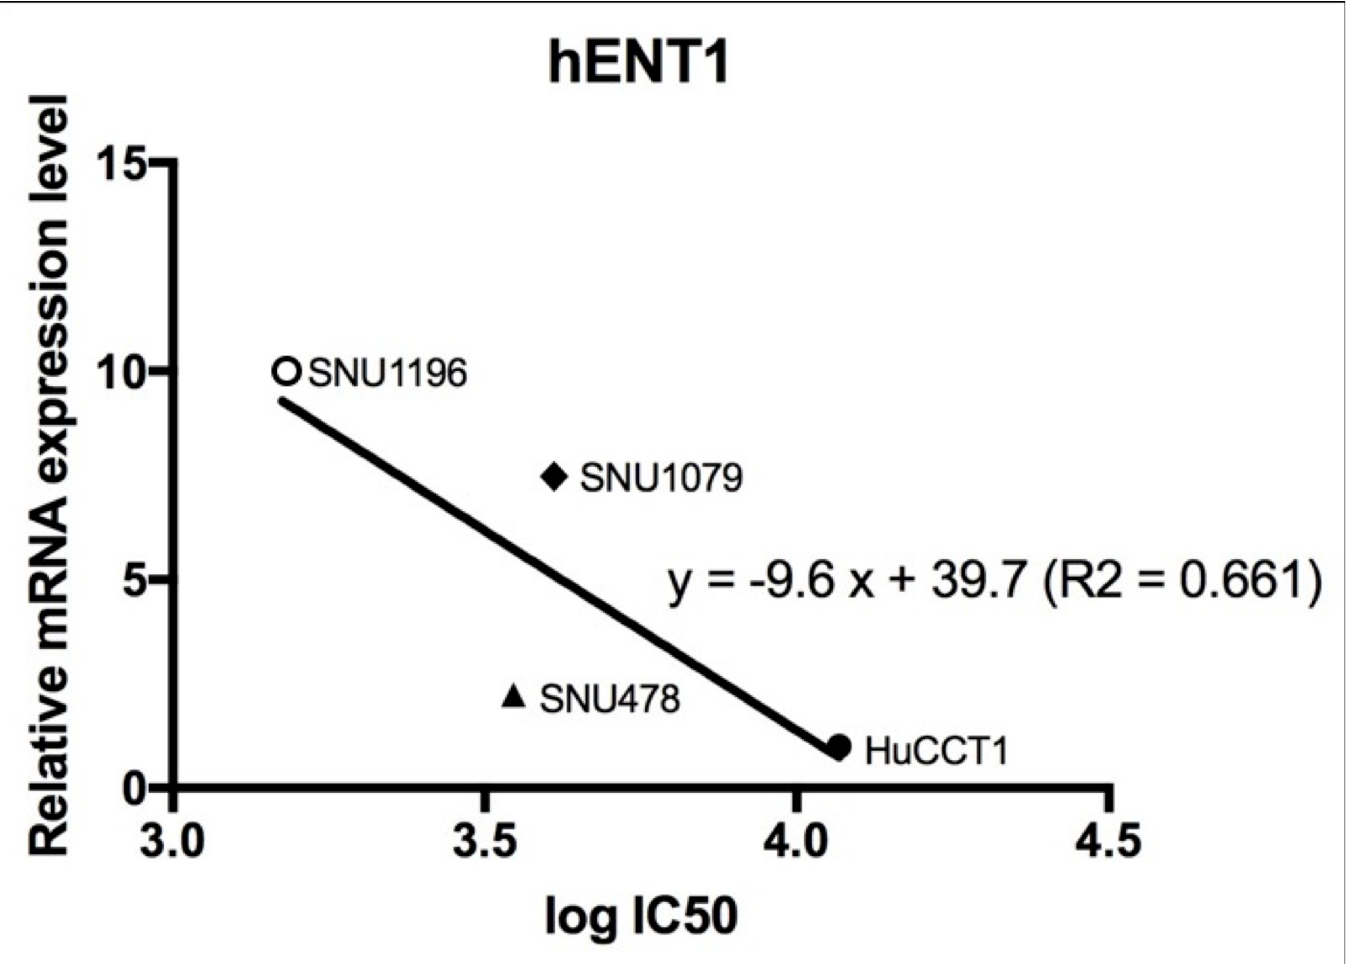
Fig 3. Correlation between gemcitabine chemosensitivity and basal expression of hENT1 mRNA. Expression of hENT1 mRNA showed a clear linear correlation with the log value of the half-maximal inhibitory concentration (IC 50 ).